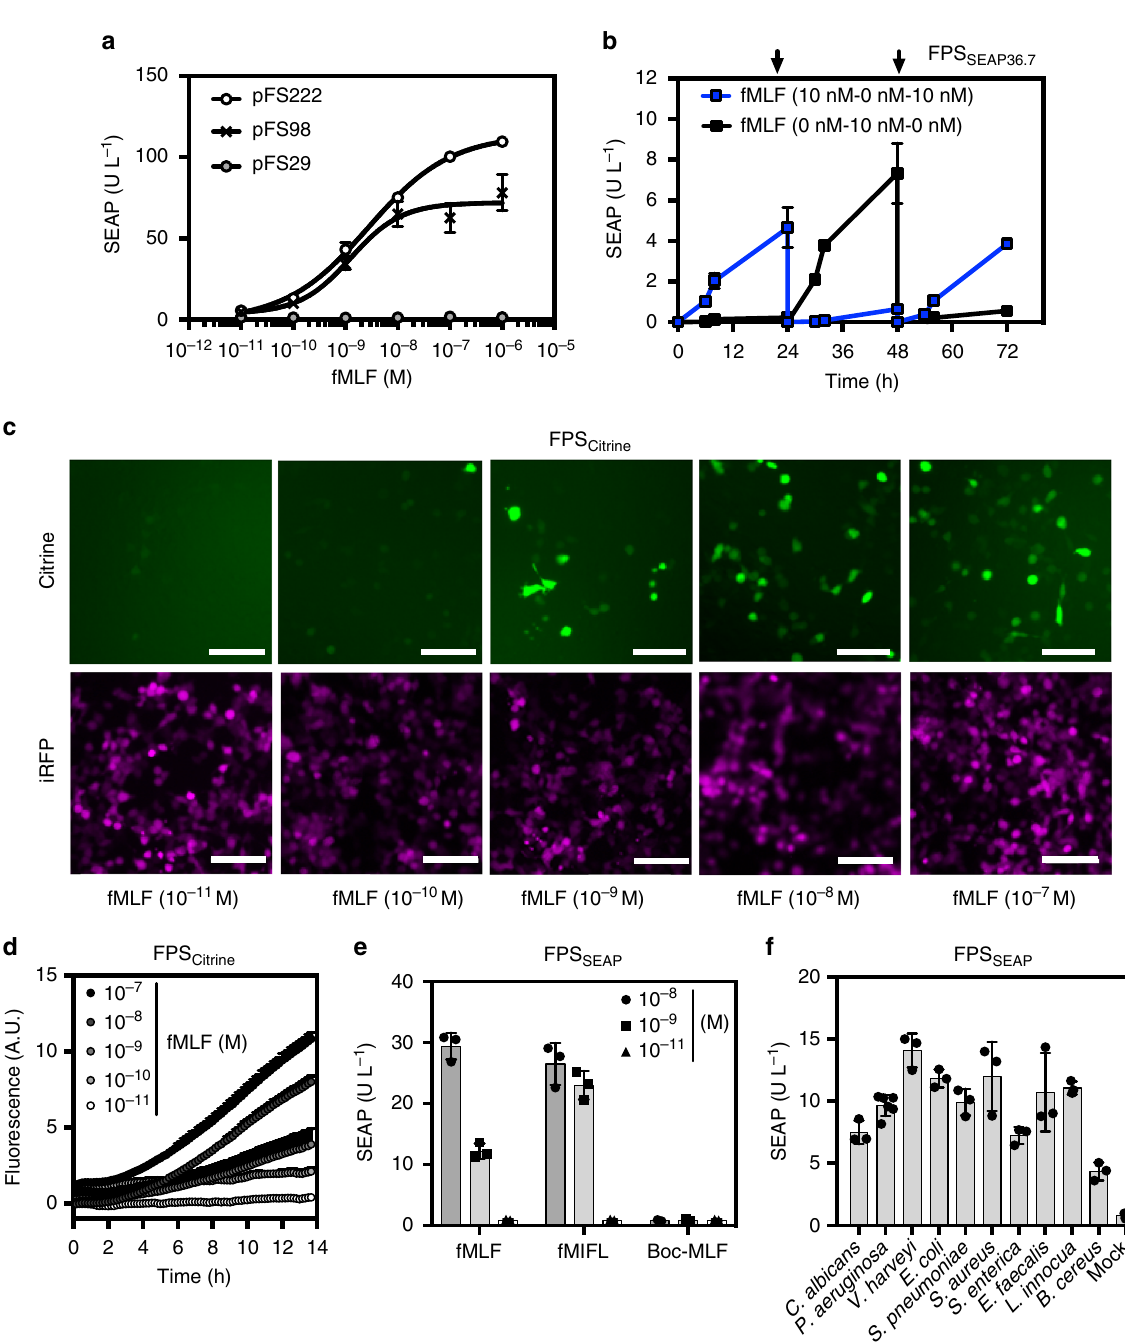
Fig. 3 Characterization of the formyl peptide transgene switch. a Formylated peptide sensitivity and adjustability of the FPS in HEK-293 cells cotransfected with pFS102 (P SV40 -G α 16 -pA) plus pYL1 (P Ca2 -SEAP-pA) and either pFS98 (P SV40 -FPR1-pA), pFS222 (P SV40 -FPR1 Δ ST-pA) or with pFS29 (P SV40